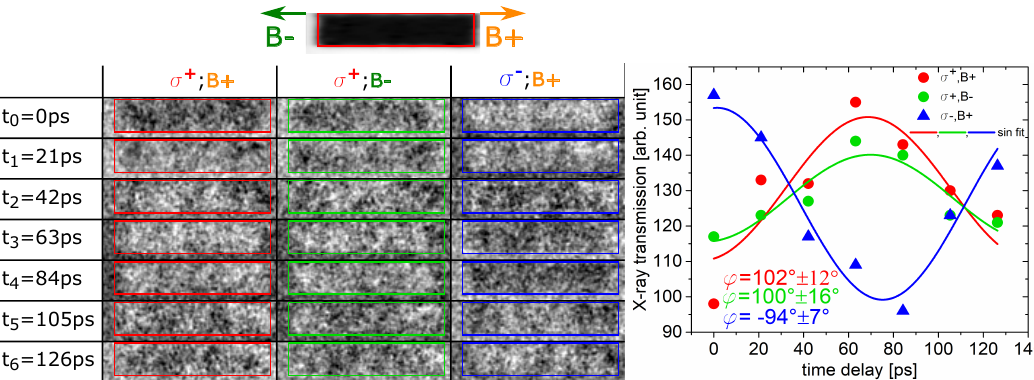
Figure 5. STXM-FMR measurement done at the Maxymus beamline at the Fe- L 3 -edge at B+ = 60mT and B- = − 60mT and different X-ray polarization σ + σ − . The applied microwave frequency for all measurements shown in this figure was 6.785GHz. The left-hand side shows the chemical contrast image together with the different directions for B- and B+. The averaged area is indicated by the red box. Below, the normalized intensity (with respect to the time average state) for the seven different excitation phases (or delay times) is shown for different field directions and X-ray polarisations. The spatially averaged intensity for each of these boxes can be found on the right-hand side with their respective colour